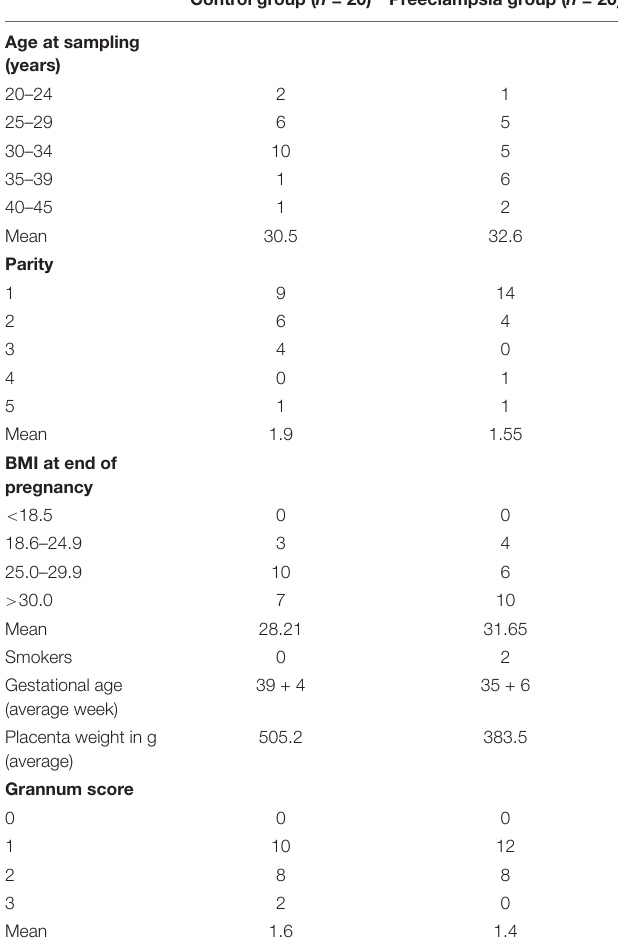
TABLE 1 | Characteristics of the study